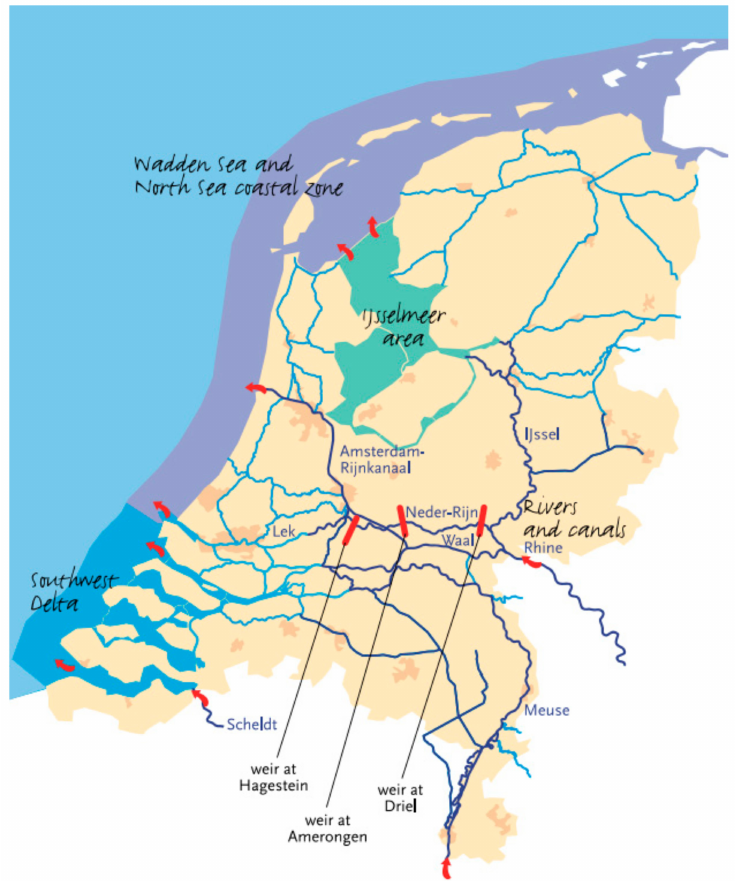
Figure 3. Layout of the water management system in The Netherlands, divided into five major areas here: the main rivers (Rhine and Meuse) and associated canals and water control structures (weirs); the Ijsselmeer area, an artificial lake created in the 1930s; the southwest Delta with fully closed, semi-closed and open river arms; the closed coastal zone along the North Sea and the tidal mudflat areas of the Wadden Sea in the north; and the “high grounds” areas with small waterways.